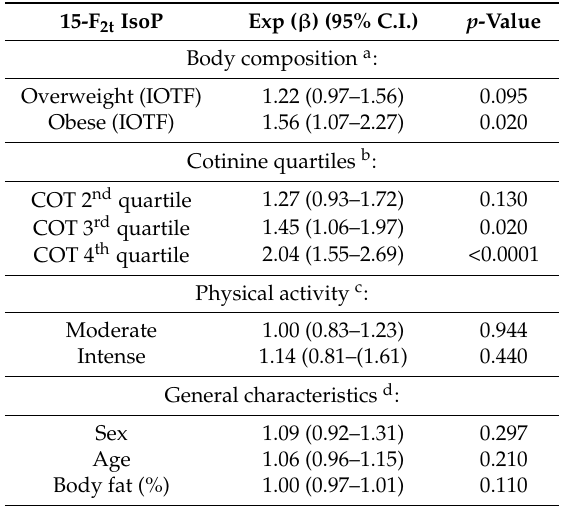
Table 2. Generalised linear model with 15-F 2t IsoP as dependent variable, fully adjusted for sex, age, body fat percentage, physical activity, BMI categories by IOTF, and cotinine quartiles.